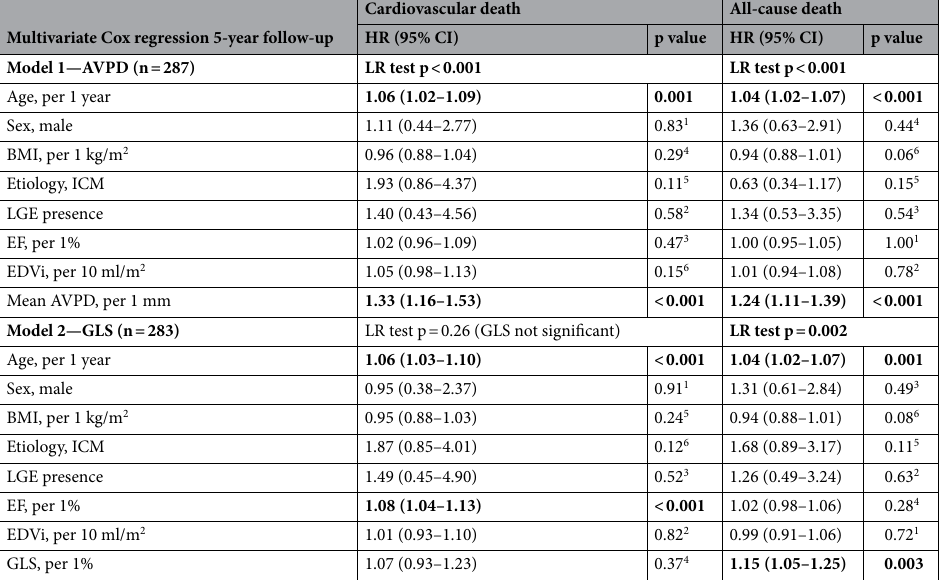
Table 3. Multivariate modeling for death in HFrEF. Bold text indicates statistical significance. HR hazard ratio, CI confidence interval, LR likelihood ratio, BMI body mass index, NYHA New York Heart Association, ICM ischemic cardiomyopathy, LGE late gadolinium enhancement, EF ejection fraction, EDVi end-diastolic volume indexed to body surface area, AVPD atrioventricular plane displacement, GLS global longitudinal strain. Log- likelihood ratio (LR)-tests assess the added prognostic values compared with nested models without AVPD (Model 1) and GLS (Model 2). Numbers in superscript represents the last step before elimination for that variable.